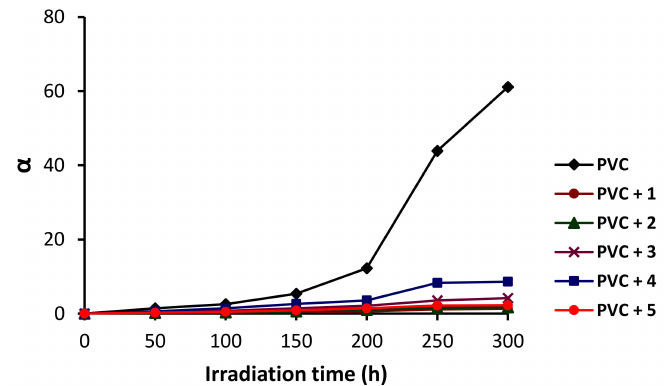
Figure 9. Changes in the α values of PVC upon irradiation.